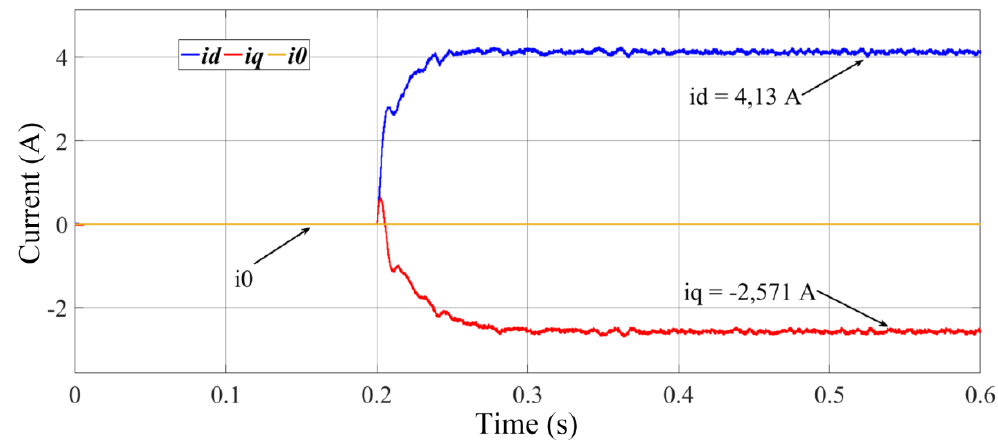
Figure 10. Direct axis current (blue) and quadrature axis current (red) measured at high voltage (HV) of system to F p = 0.85. Vertical axis: 2 A/div. Horizontal axis: 100 ms/div.